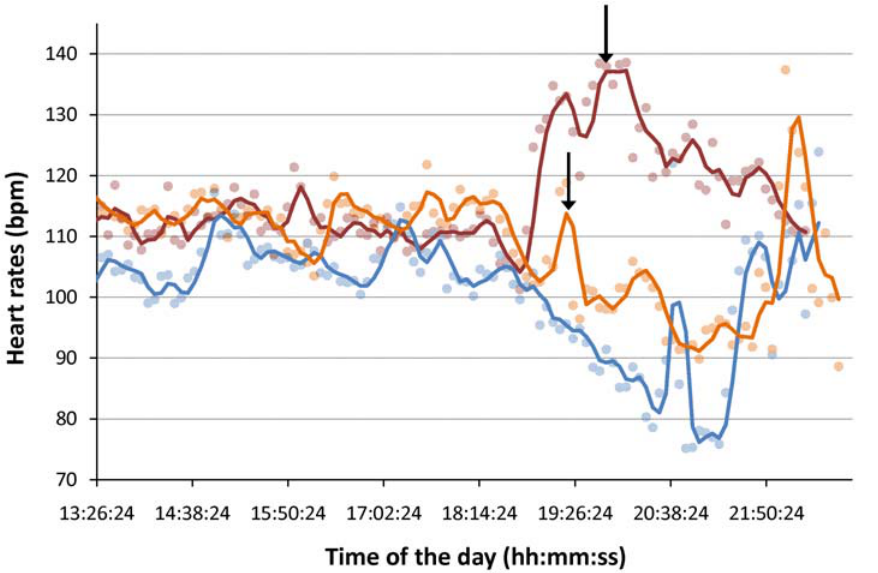
Figure 2. Heart rates of Crimson (red), Nugget (orange) and Nemo (blue), averaged every 5 minutes (dots) over the whole recording periods. A curve depicting the moving average of the heart rate, calculated with a 3 points step is superimposed on the dots. Note the drastic change in heart rate around 6:30 PM for all koalas. Arrows indicate the time at which an experimenter walked around the trees of Crimson and Nugget.